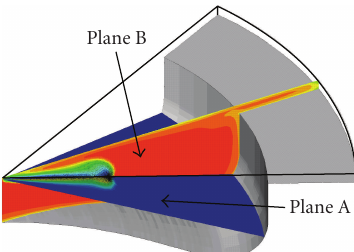
Figure 12: Computational grid of the heavy duty DI diesel engine.